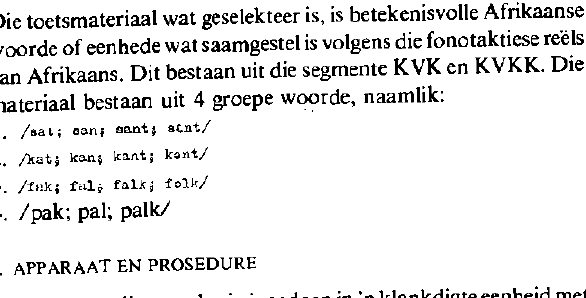
Aspekte van Tydreeling in Normale en Verbaal-Apraktiese Spraak